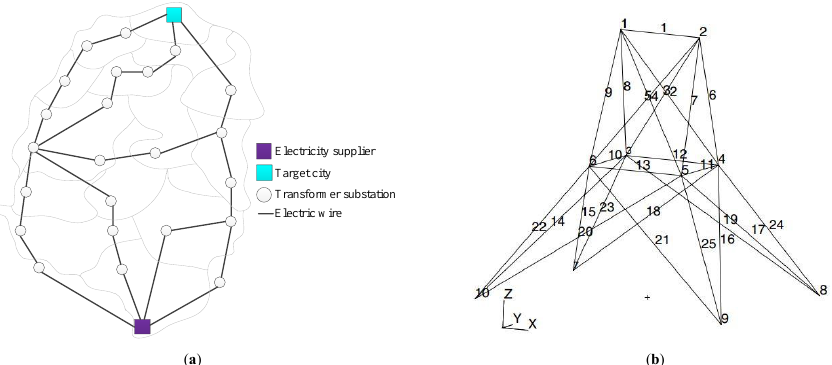
Figure 12. A schematic view of an electrical power network system. ( a ) An electric power network system; ( b ) Transformer substation. The transformer substation is a 25-bar space truss structure whose material mass density is 0.1. The three coordinates of each node and the member grouping information are listed in Table 3 and Table 4, respectively. The cross- sectional area and Young’s modulus of the bar at each group are denoted 𝐴 I –𝐴 VI and 𝐸 I –𝐸 VI , respectively. Four